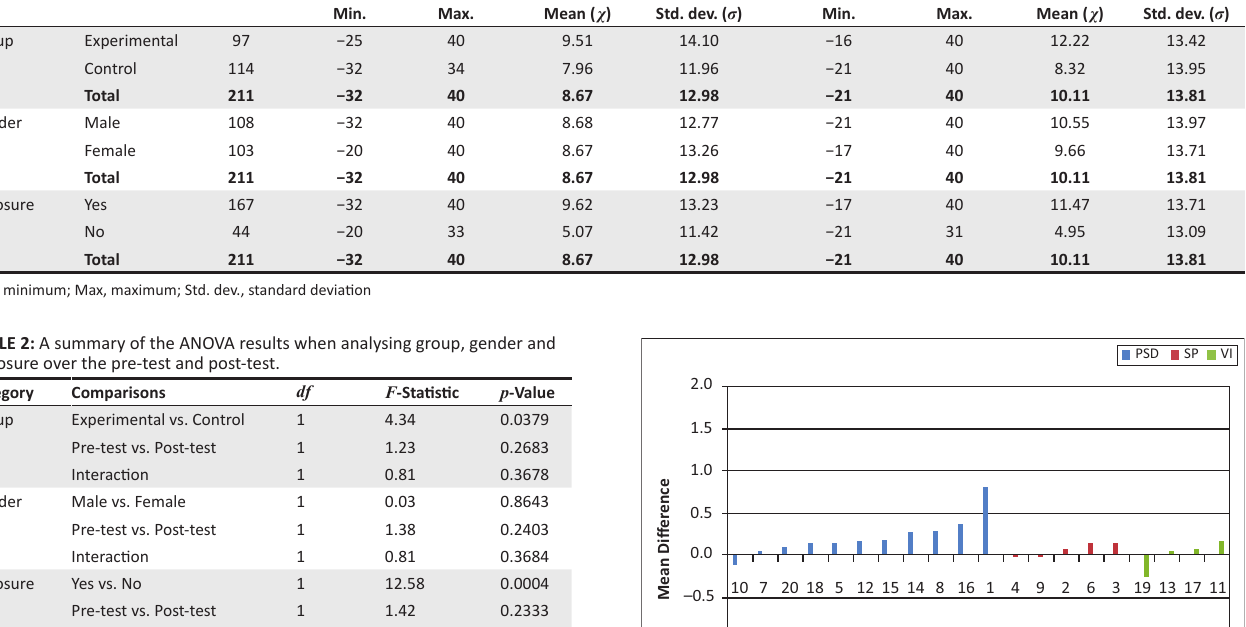
TAble 1: Total score by group, gender and exposure; pre-test vs. post-test. Category